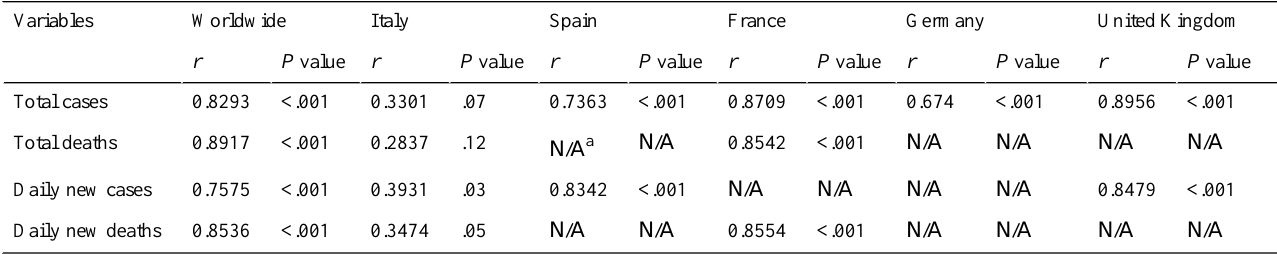
Table 1. Pearson correlation coefficients ( r ) between Google Trends and COVID-19